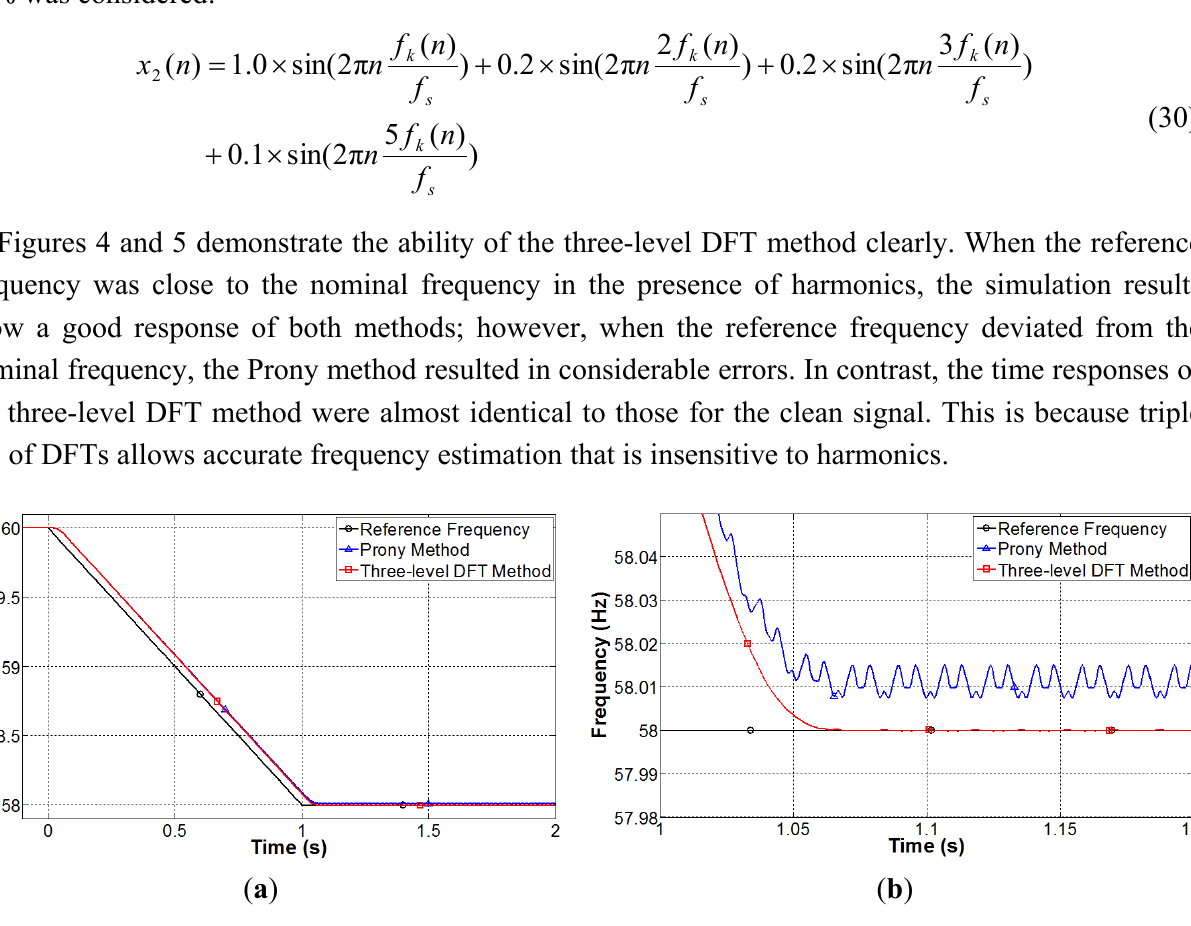
Figure 4. Estimation of a ramp-down frequency variation in the presence of harmonics.